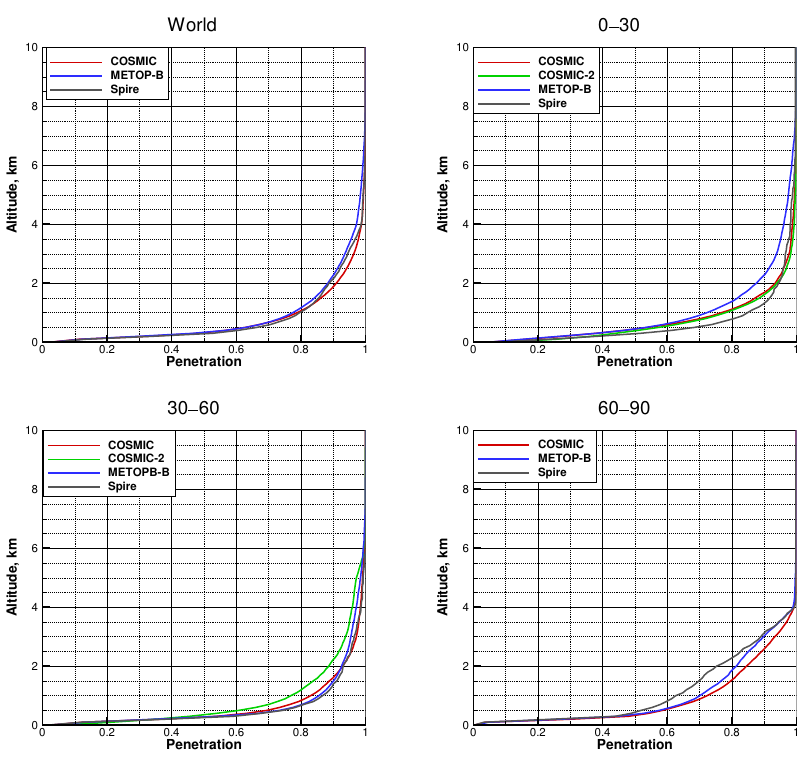
Figure 16. Similar to Figure 14. Penetration, dynamic